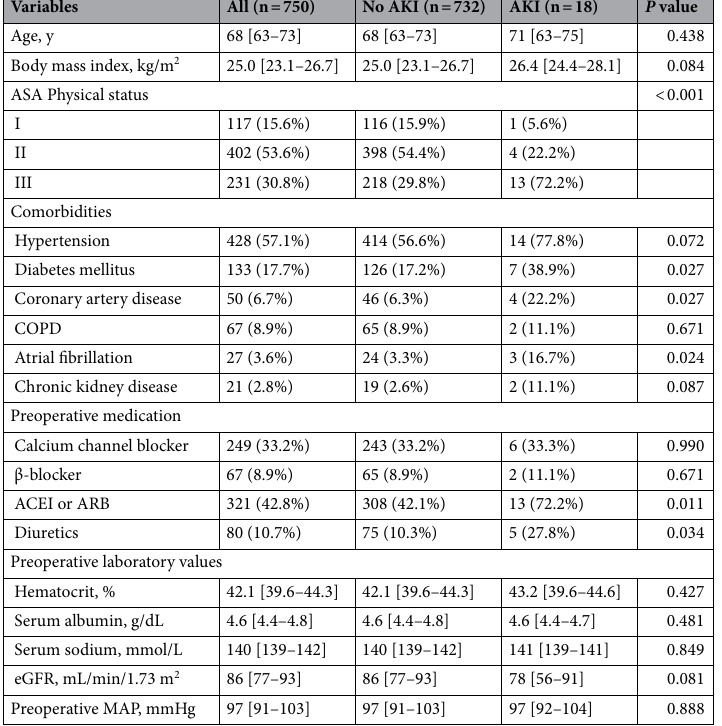
Table 1. Patient characteristics. Values are median (interquartile rage) or number of patients (percentage). AKI acute kidney injury, ASA American Society of Anesthesiology, ACEI angiotensin-converting enzyme inhibitor, ARB angiotensin receptor blocker, COPD chronic obstructive pulmonary disease, eGFR estimated glomerular filtration rate, MAP mean arterial